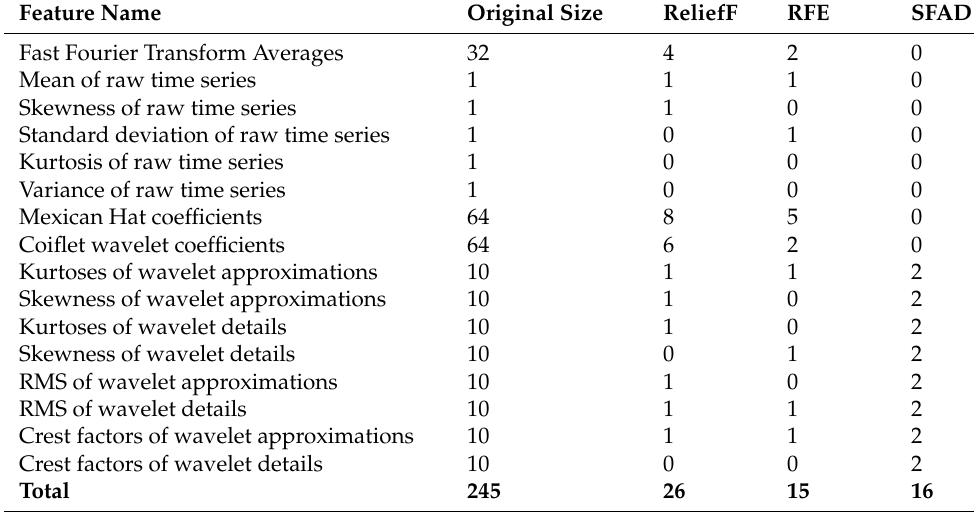
Table 2. Features extracted from vibrations